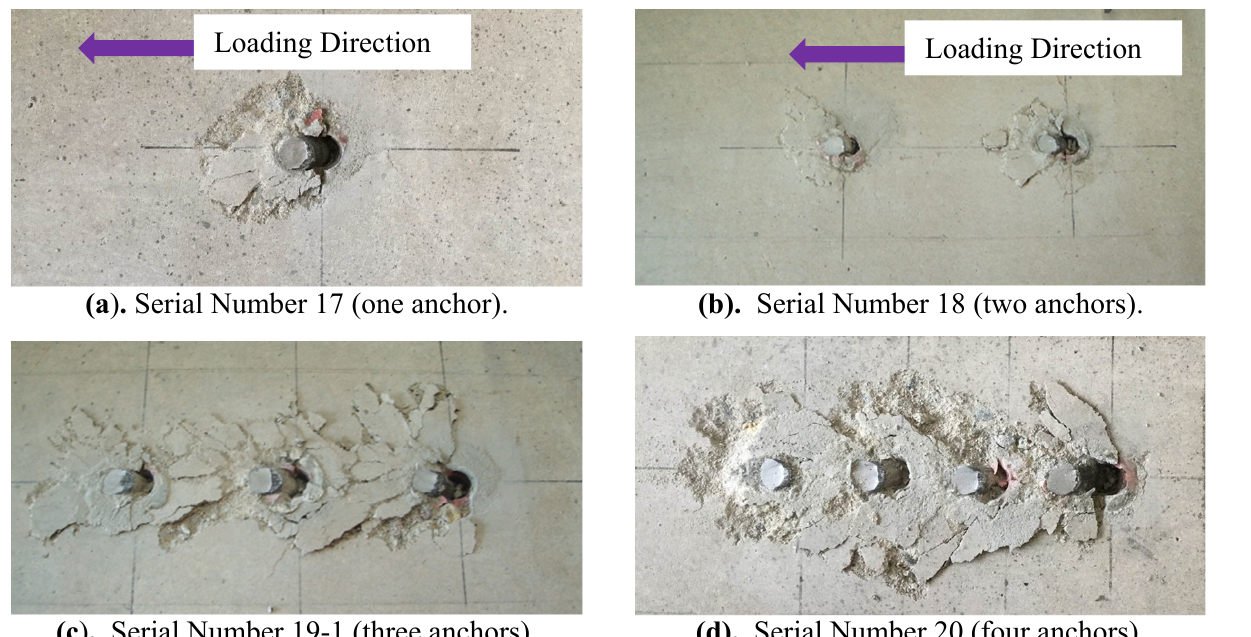
Figure 3. Examples for Crack Patterns of Concrete and Shear Ruptures of Anchors.